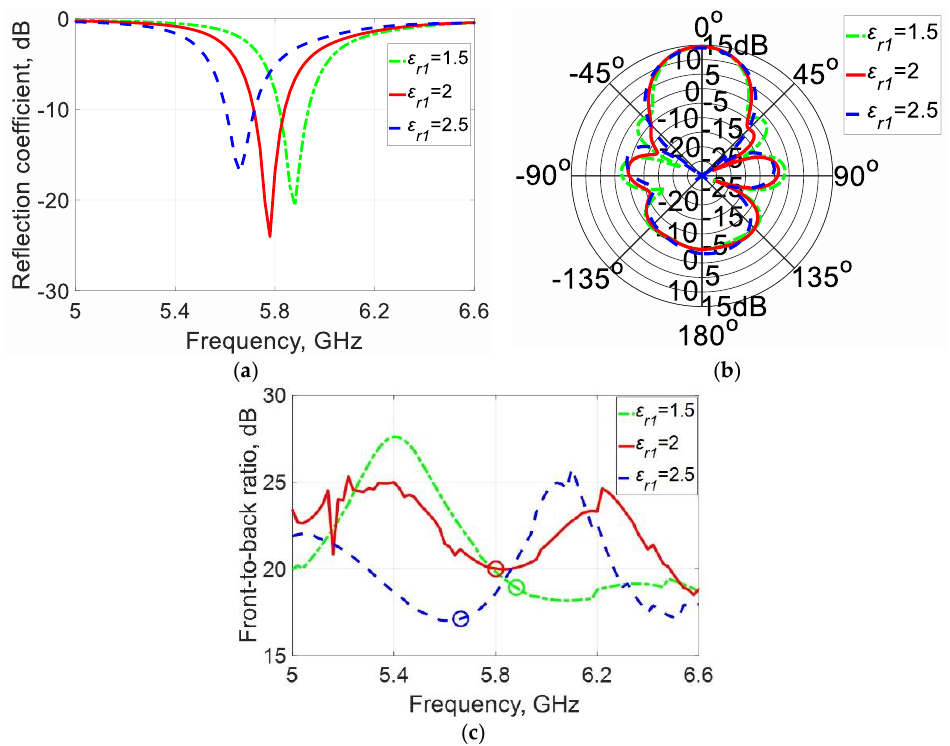
Figure 3. Parametric study of the dielectric constant ( 𝜀 𝑟1 ) of the light green section. ( a ) Reflection coefficient. ( b ) 𝜃 -sweep radiation pattern ( 𝜙 = 0° ). ( c ) Front-to-back ratio.